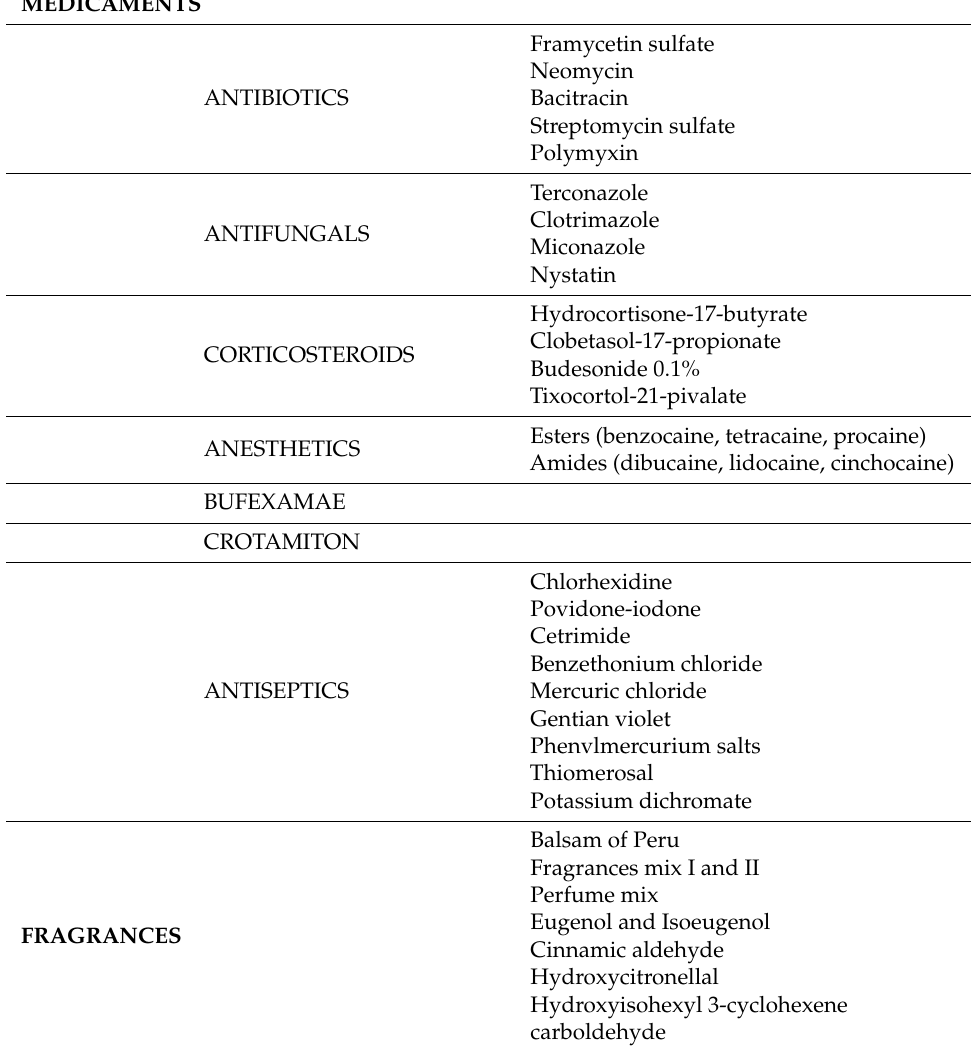
Table 3. List of the most common fragrances and medicaments responsible for vulvar